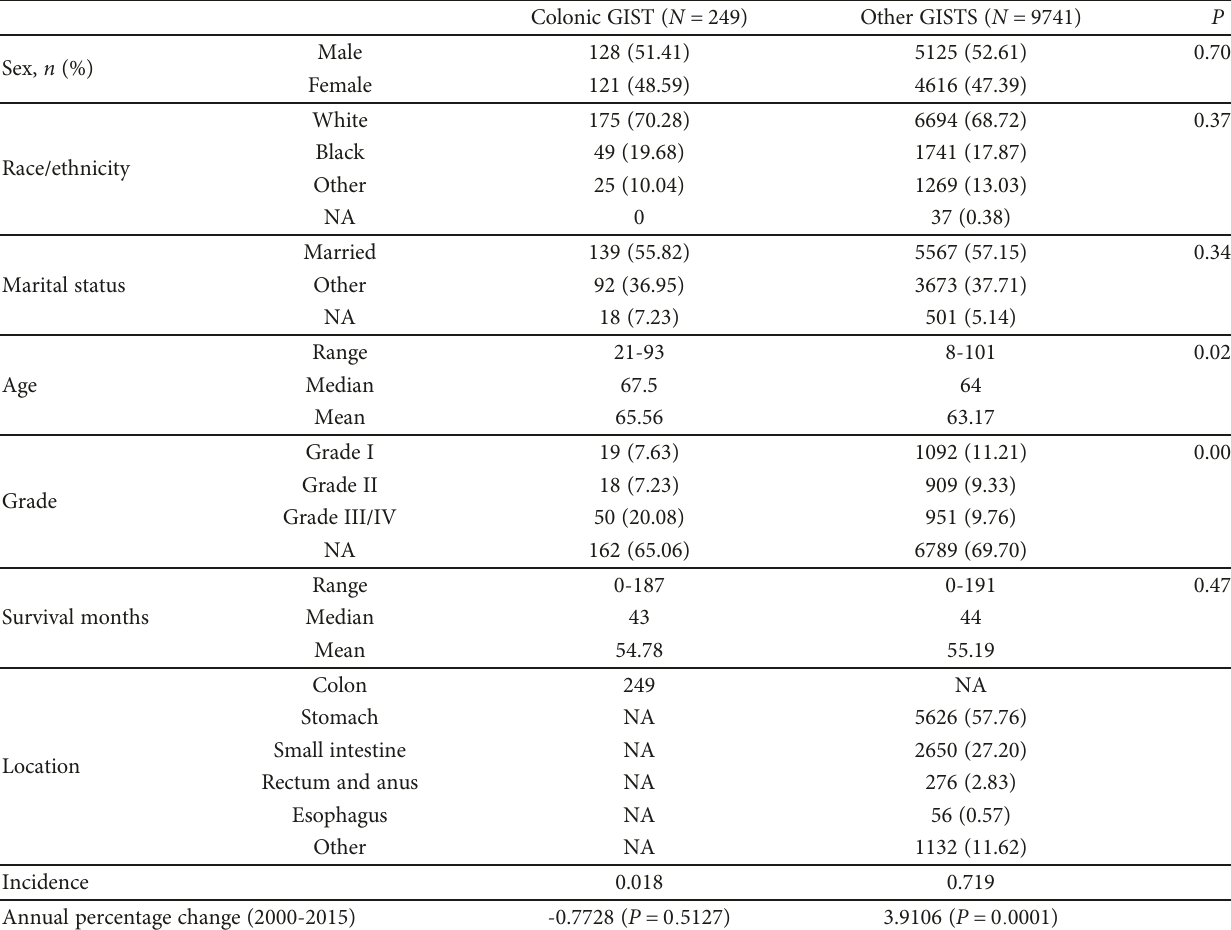
Table 1: Patient demographics and